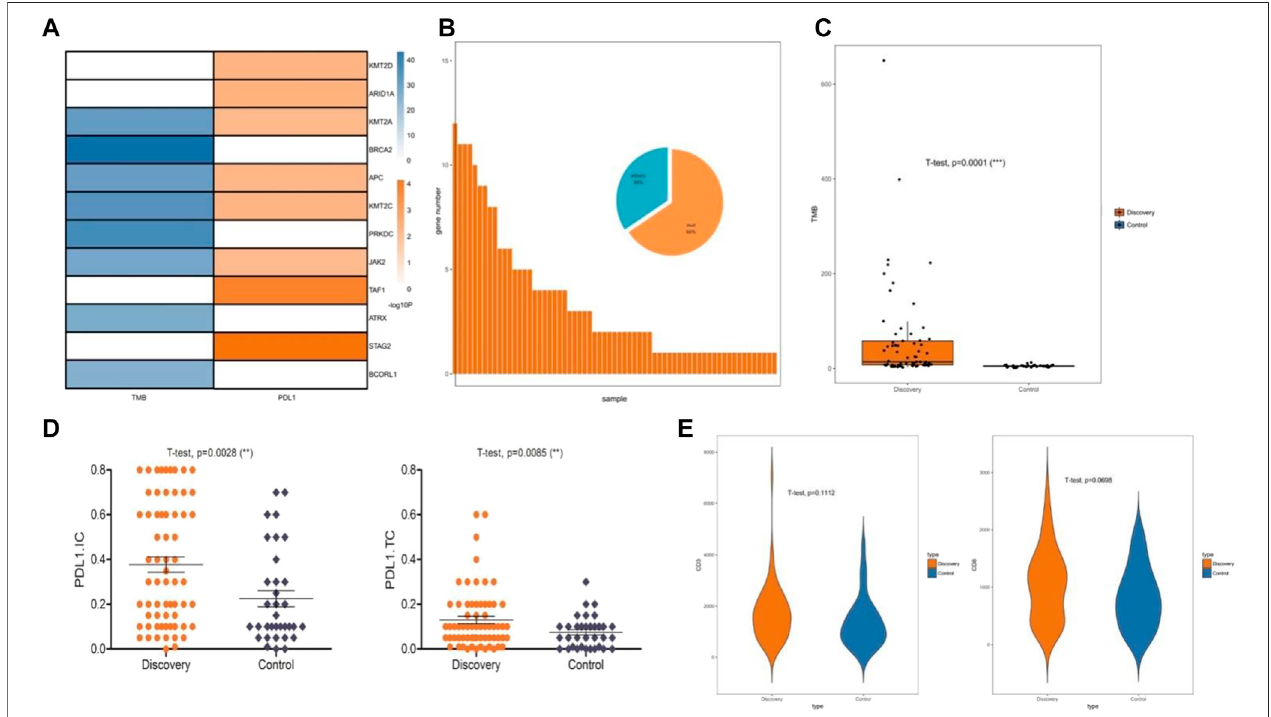
FIGURE2| Immunemicroenvironmentcorrelatedwithchromatinstatus-relatedgenes. (A) Speci fi cmutatedgenesscreenedbysigni fi cantcorrelationwiththePD- L1 (programmed death-ligand 1) expression or TMB (tumor mutational burden), Pearson ’ s correlation coef fi cient was used to assess correlations. (B) Mutations of 12 speci fi c mutated genes were identi fi ed as a discovery set. (C) Relationship between the discovery sets and TMB. (D) Relationship between the discovery sets and PD-L1 expression. (E) Relationship between the discovery sets and CD3 + and CD8 + T cell in fi ltration.